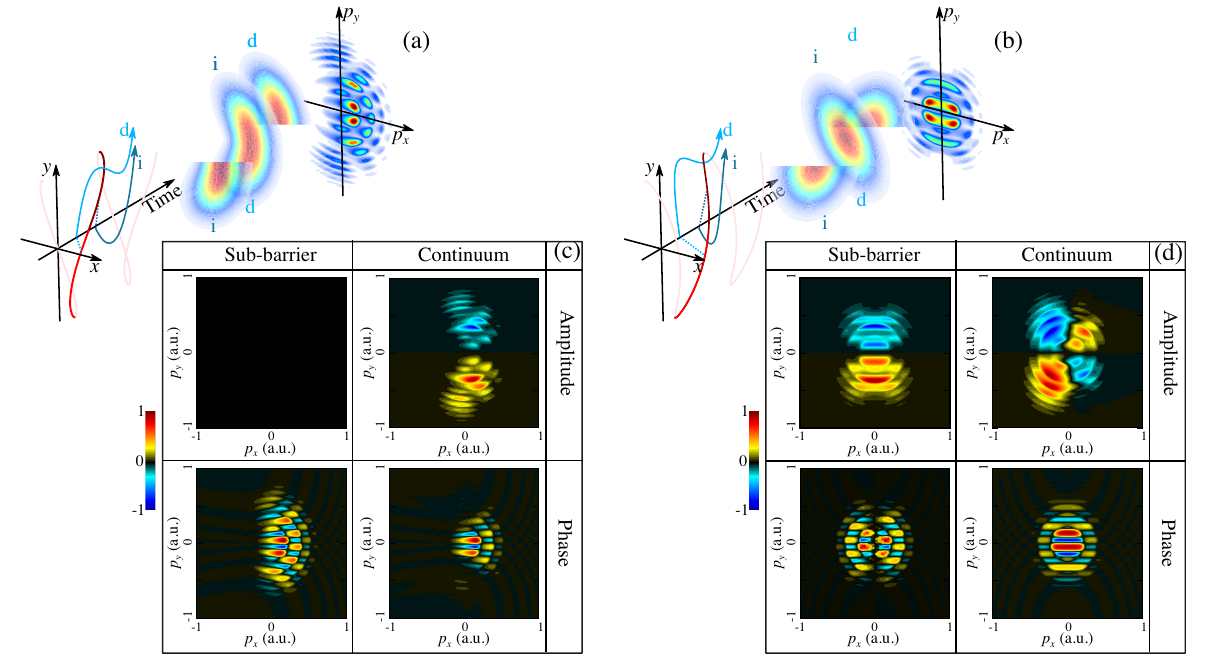
FIG. 5. Chiral strong-field photoelectron interferometry. (a) Schematic drawing of direct “ d ” and indirect “ i ” electron paths associated to the ionization of a target with 7.2 eV ionization potential by an 8-shaped OTC field (shaded red line) with I ω ¼ 5 × 10 13 W · cm − 2 and r ¼ 0 . 1 . These electron paths belong to delayed wave packets whose asymptotic momentum shapes are reported in terms of shaded contour plots (SFA calculations). The direct and indirect wave packets finally interfere, yielding a clear angular fringe pattern on the electron detector. (c) Projected forward-backward asymmetries Δ P f=b ð p x ; p y Þ modeled by the chiral-SFA approach, assuming different sources of chiral response — amplitude vs phase effects coupled to sub-barrier vs continuum dynamics. These asymmetries are arbitrarily normalized. (b) and (d) are the same as (a) and (c) but relative to a C -shaped OTC